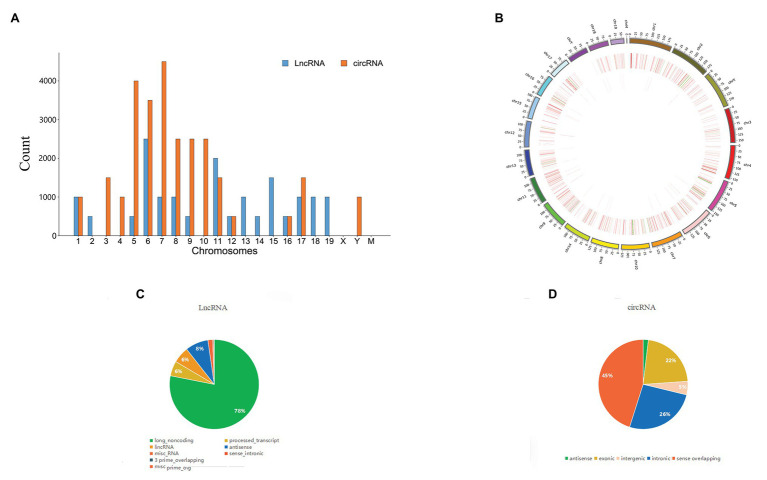
Comparison of the characteristics of lncRNA, circRNA, and mRNA expression profiles in pancreatic tissues between SAP group and control group. (A) The distribution of lncRNAs and circRNAs on chromosomes, (B) LncRNAs and mRNAs on chromosomes. (C,D) Biotypes of lncRNAs and circRNAs.